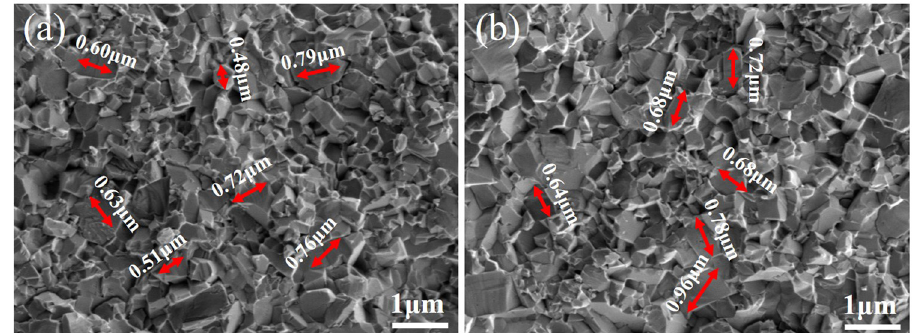
Figure 11: SEM images of ( a ) WCN - 5# fracture and ( b ) WCN - 6# fracture.